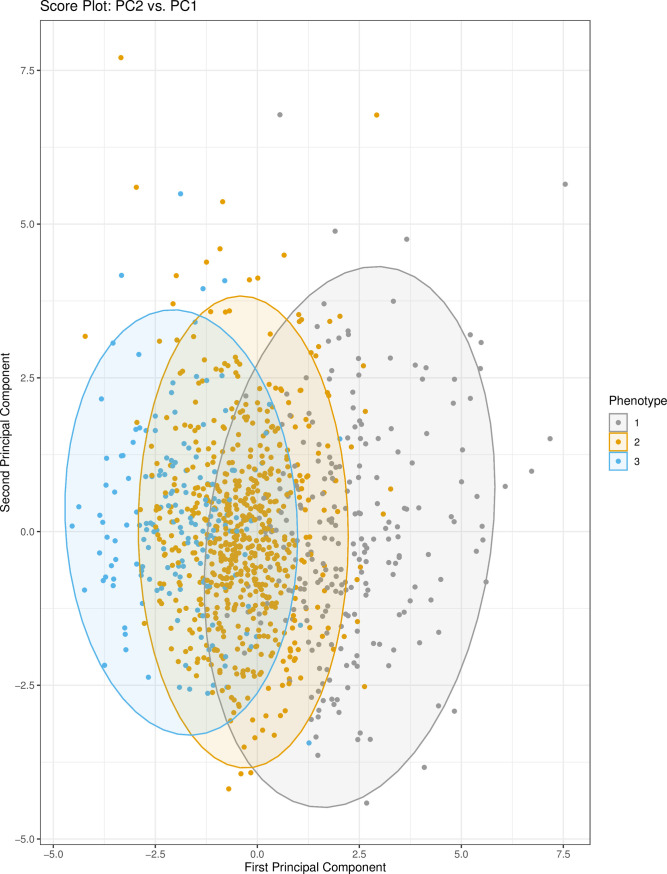
Score plot: PC2 vs. PC1.The principal component scores for PC1 and PC2 are plotted. Each point represents a patient in the dataset. Colors represent the cluster (phenotype) that the patient was assigned to by consensus clustering. Ellipses around each cluster/phenotype specify 95% confidence intervals, assuming a bivariate normal distribution. Abbreviations: PC1 (principal component 1); PC2 (principal component 2).